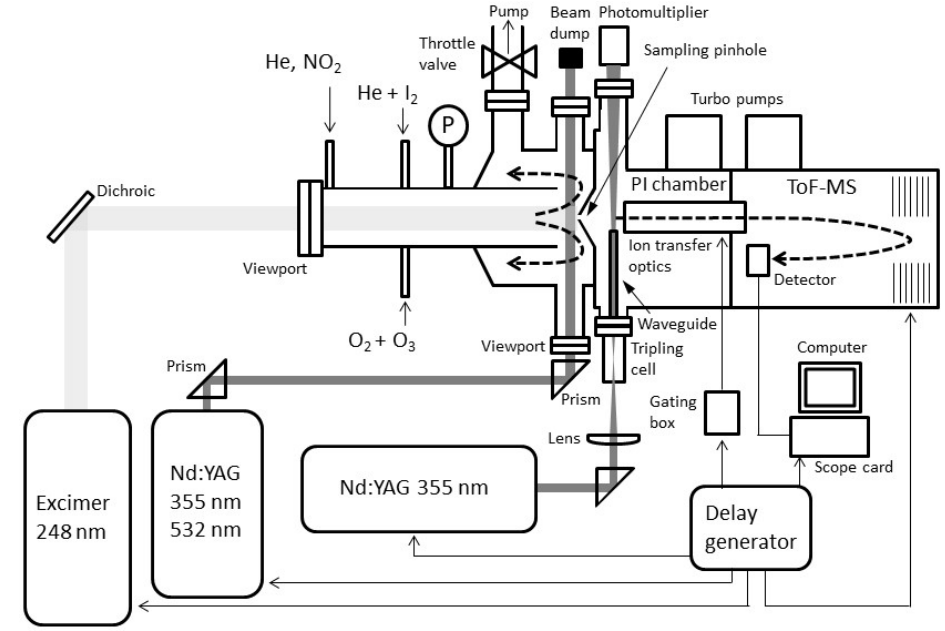
Figure 1. Schematic diagram of the experimental set-up for studying the photolysis of iodine oxides.